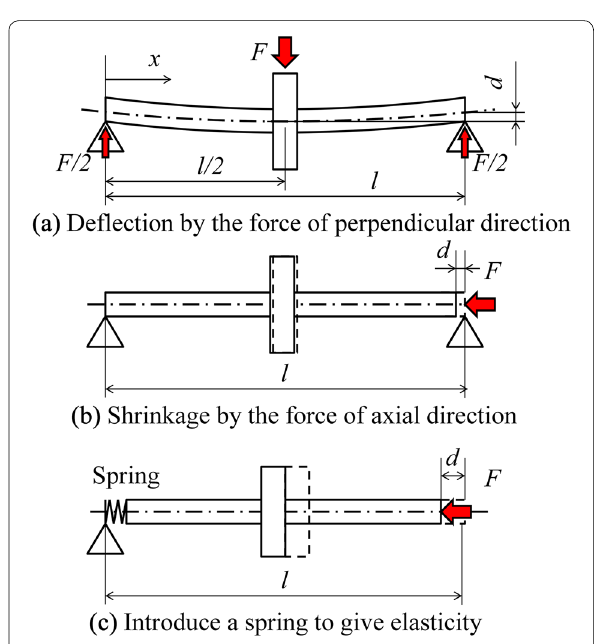
Fig. 2 Bending and shrinkage models of the shaft of the worm